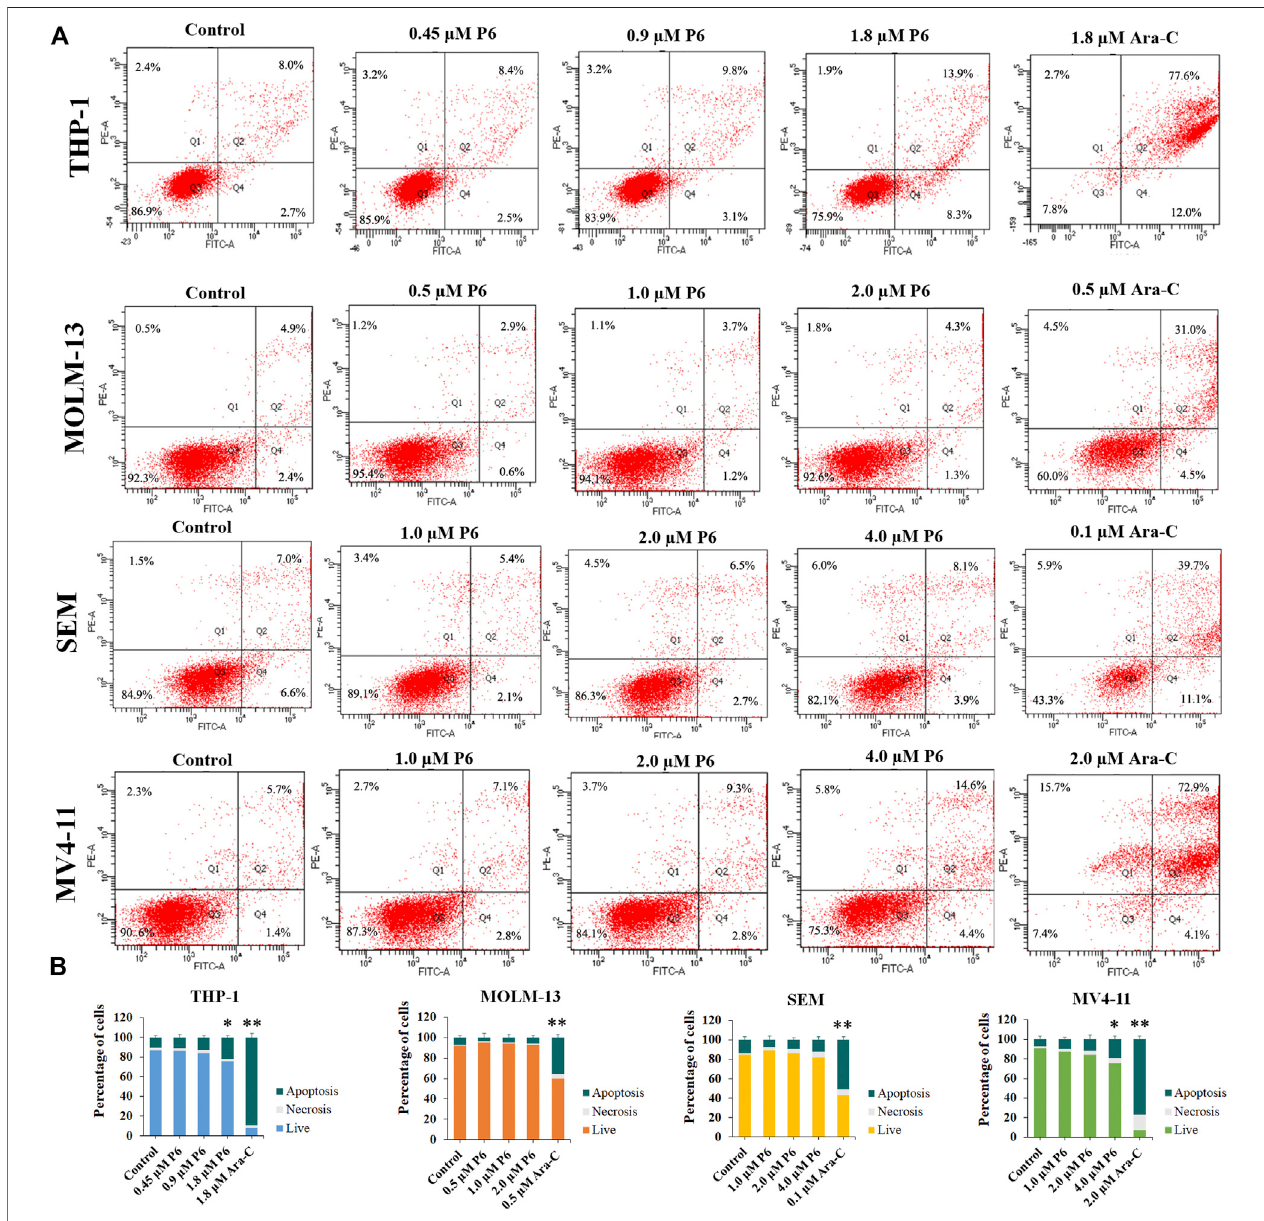
FIGURE 6 | Molecule P6 does not induce signi fi cant apoptosis in THP-1, MOLM-13, SEM and MV4-11 cells. (A) Cells were treated with P6 or Ara-C for 72 h and cell apoptosis was determined by fl ow cytometric analysis. (B) Graph illustration of the percentage of living cells and cells undergoing necrosis/apoptosis (* p < 0.05, ** p <